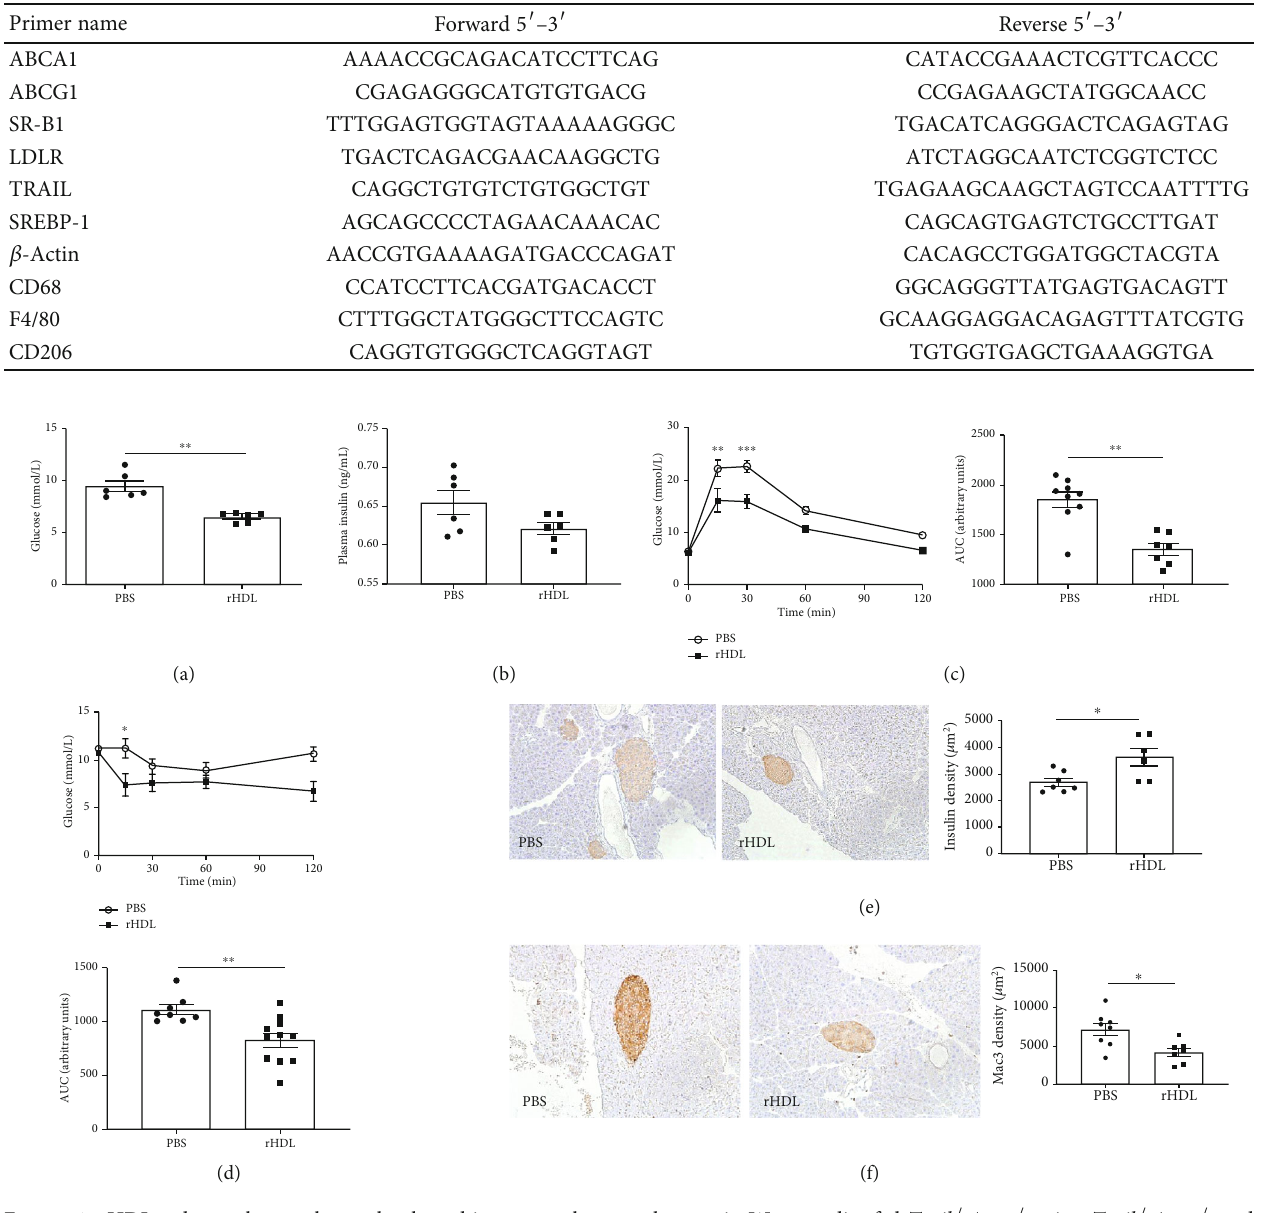
Figure 1: rHDL reduces plasma glucose levels and improves glucose tolerance in Western diet-fed Trail -/- Apoe -/- mice. Trail -/- Apoe -/- and Apoe -/- mice were fed a high-fat Western diet for 12 weeks. In the last 2 weeks of the study, mice received 3 weekly infusions of either rHDL (20 mg/kg) or PBS. At the conclusion of the study (a) fasting plasma glucose and (b) fasting plasma insulin were measured; n = 6 /group. (c) Glucose and (d) insulin tolerance tests were performed as described in the methods at 12 weeks where plasma glucose levels were measured over 2 hours ( n = 8 -10). PBS-treated Trail -/- Apoe -/- (open circles); rHDL-treated Trail -/- Apoe -/- (closed squares). The area under the curve (AUC) was quanti fi ed for each. Mouse pancreatic islets were stained for (e) insulin and (f) macrophages (MAC3). Left panel: representative images of stained pancreata. Right panel: quanti fi cation ( n = 6 -8). Results are expressed as mean ± SEM ; ∗ p < 0 : 05 , ∗∗ p < 0 : 01 , and ∗∗∗ p < 0 : 001 , Mann – Whitney t - test and ANOVA used in all conditions. rHDL: reconstituted high-density lipoprotein.